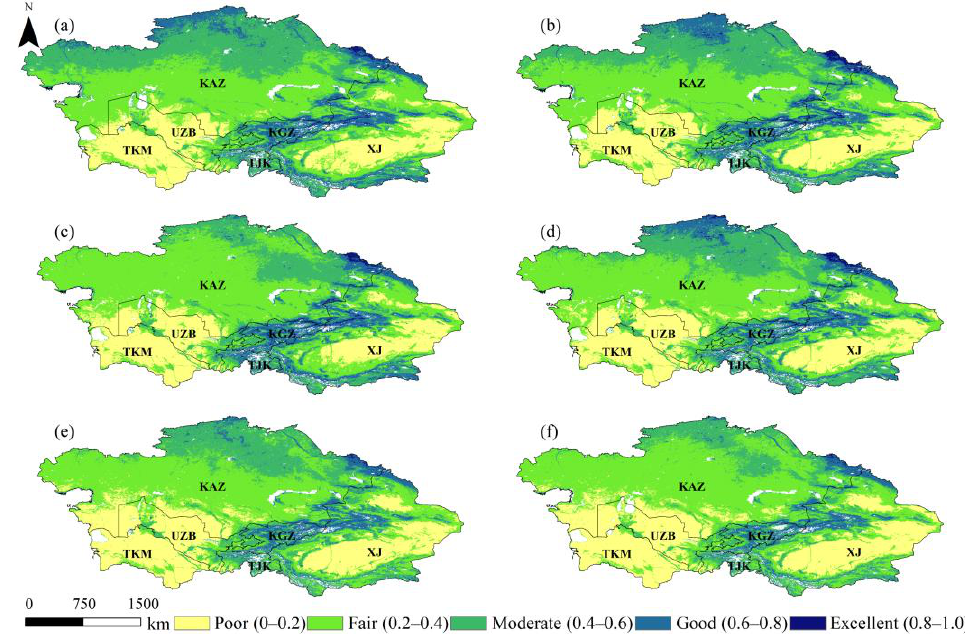
Figure 3. RSEI variation in CA (( a – f ) are 2000, 2005, 2010, 2015, 2020, and the mean of 2000 – 2020, respectively). Table 2. Area and percentage change of each RSEI level in CA and its six